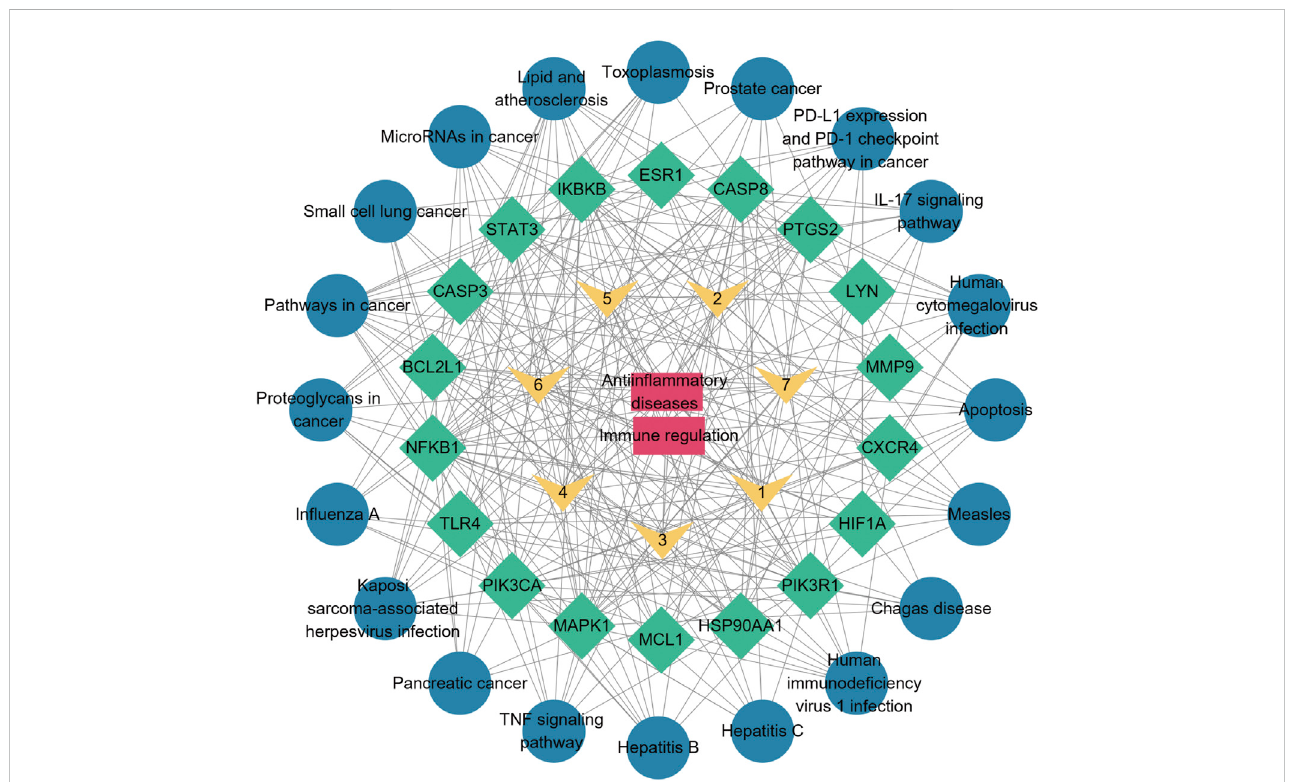
FIGURE 8 Network of “ drug(bioactive peptide)-disease-target-pathway ” . Red nodes represent diseases; yellow nodes represent bioactive peptides; green nodes represent key targets; blue nodes represent pathways and the line segments represent the relationship between the two.